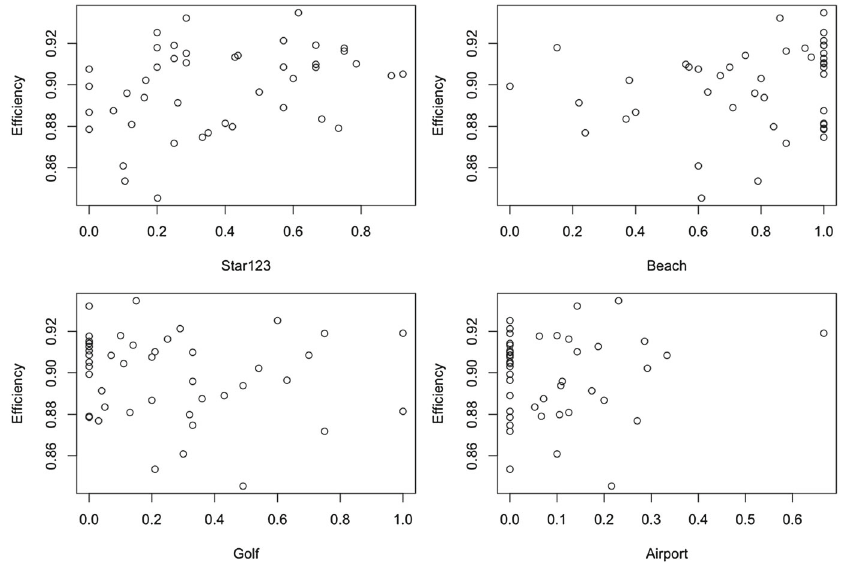
Fig. 2 Scatter plots showing the relation between the estimated efficiency and the exogenous variables: proportion of beach hotels (Beach), proportion of hotels with 3 stars or fewer (Star123), proportion of hotels with golf facilities (Golf) and proportion of hotels less than 10km from an